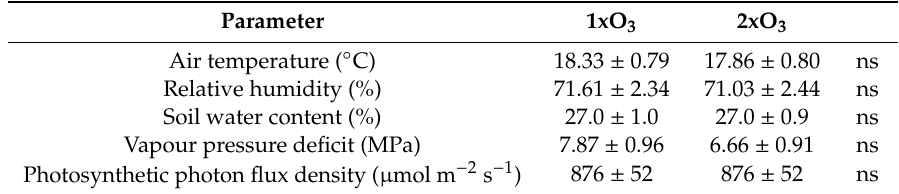
Table 1. Mean daily environmental parameters ( ± Standard Error) did not di ff er between 1xO 3